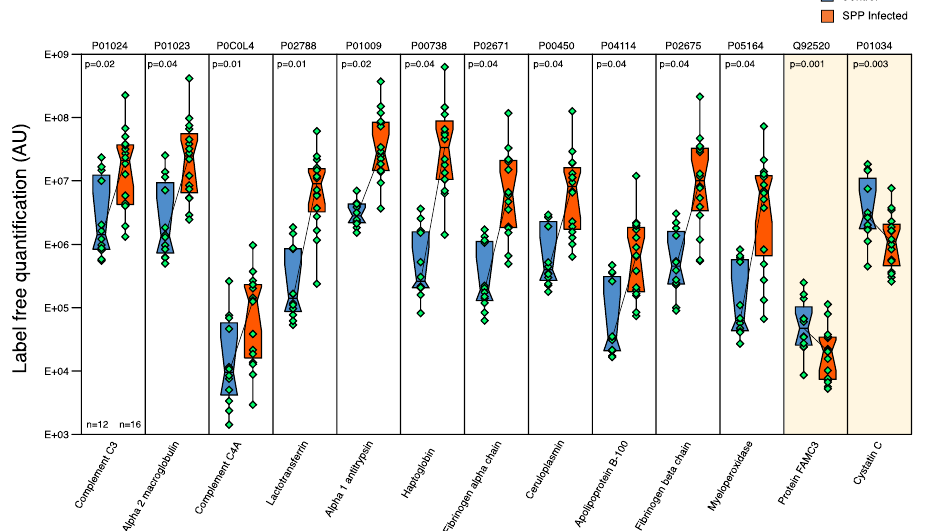
Figure 5. Label-free quantification of confidently identified and quantified proteins. Whiskers indicate the 95% and 5% boundaries of the data and the horizontal bar within the box is the median. Control samples are blue and SPP are red. Yellow shading is used to highlight the two proteins present at lower levels in SPP. Proteins are defined by their UniProtKB ID P01024 : Complement C3, P01023 : Alpha-2-macroglobulin, P0C0L4 : Complement C4-A, P02788 : Lactotransferrin, P01009 : Alpha-1-antitrypsin, P00738 : Haptoglobin, P02671 : Fibrinogen alpha-chain, P00450 : Ceruloplasmin, P04114 : Apolipoprotein B-100, P02675 : Fibrinogen beta chain, P05164 : Myeloperoxidase, Q92520 : Protein FAM3C, P01034 : Cystatin-C. Probabilities were calculated using the t-test function in R and corrected for multiple testing by Benjamini and Hochberg method. Corrected p-values are shown in the panels. Individual data points are shown for controls (n = 12) and SPP (n = 16)